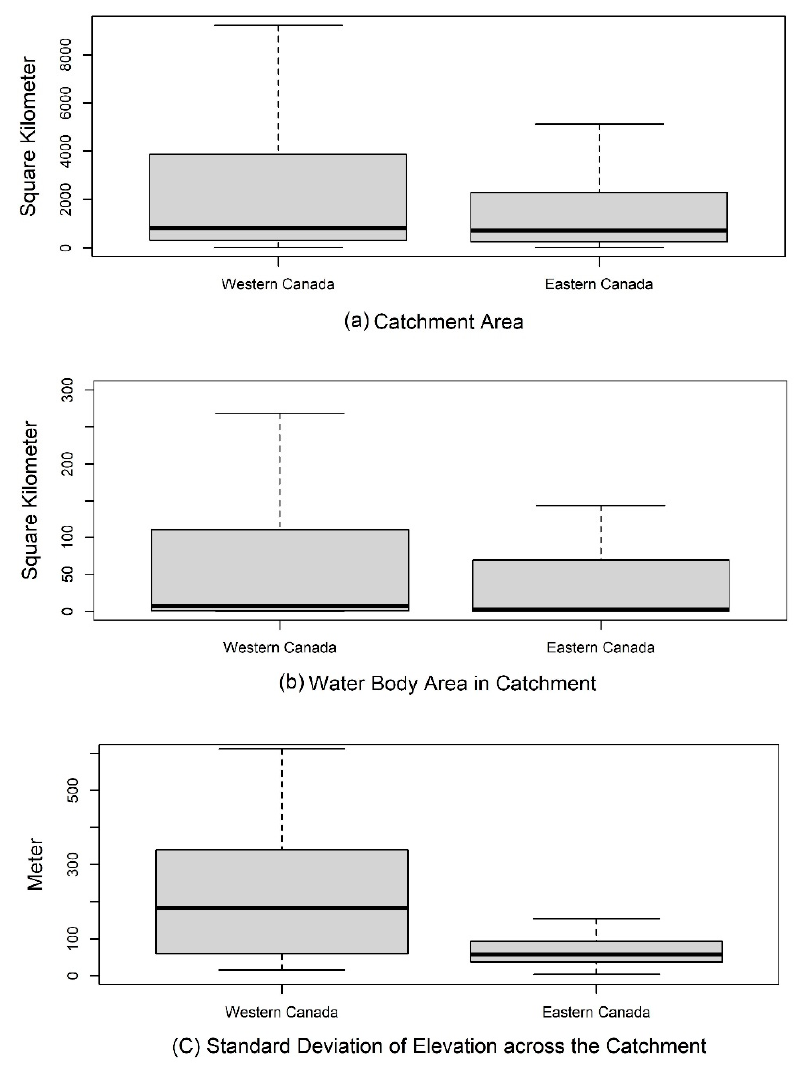
Figure 6. Boxplots comparing physiographic variability of eastern and western sites across Canada. Eastern (Western) computed based on 76 (110) sites; Ontario-Manitoba border is considered the east–west divide, respectively. Boxes represent 25th and 75th percentiles and the median (black line); whiskers extend to extreme values without outliers, where outliers are defined as 1.5 the interquartile range (outliers are removed for scaling purposes).